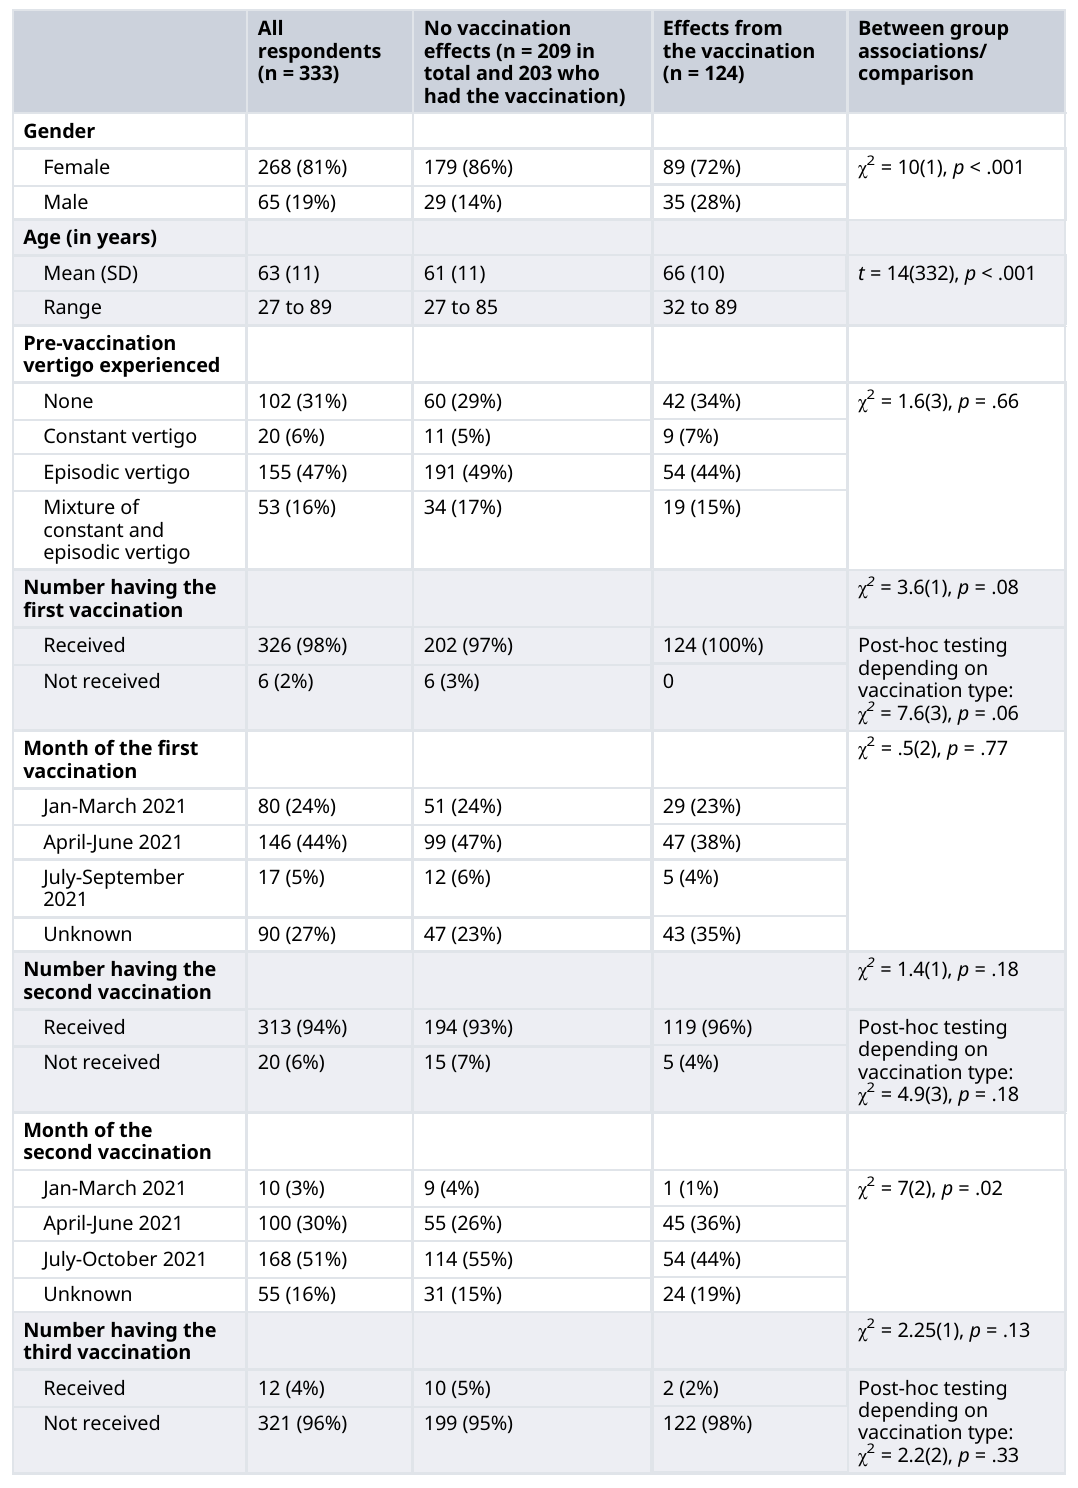
Table 1. Demographic profile of the respondents and comparison of those with and without general vaccination effects.